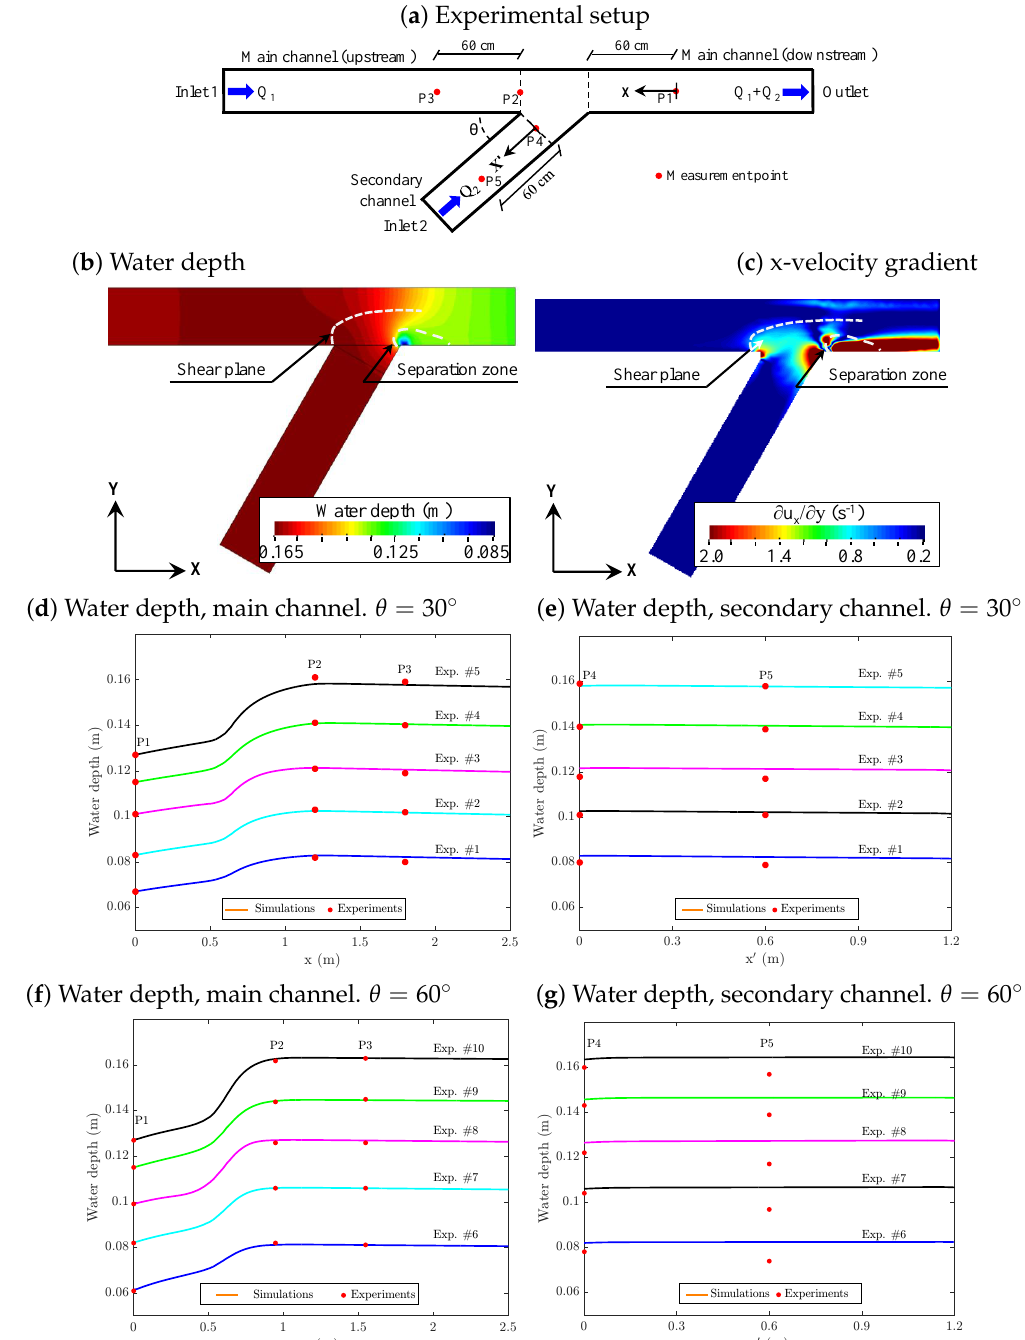
Figure 2. Validation of the numerical hydraulic model with laboratory experiments. ( a ) Setup of the laboratory experiments. ( b ) Contour plot of the water depth computed with the numerical model. Experiment # 10. ( c ) Contour plot of the x-velocity gradient given by ∂ U x / ∂ y computed with the numerical model. Experiment # 10. ( d ) Water depth for the model with θ = 30 ◦ along the main channel, and ( e ) along the secondary channel. ( f ) Water depth for the model with θ = 60 ◦ along the main channel, and ( g ) along the secondary